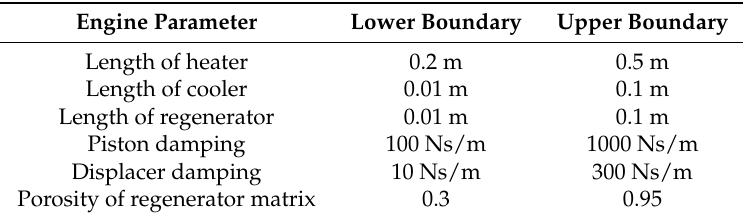
Table 3. Constraints for the FPSE design